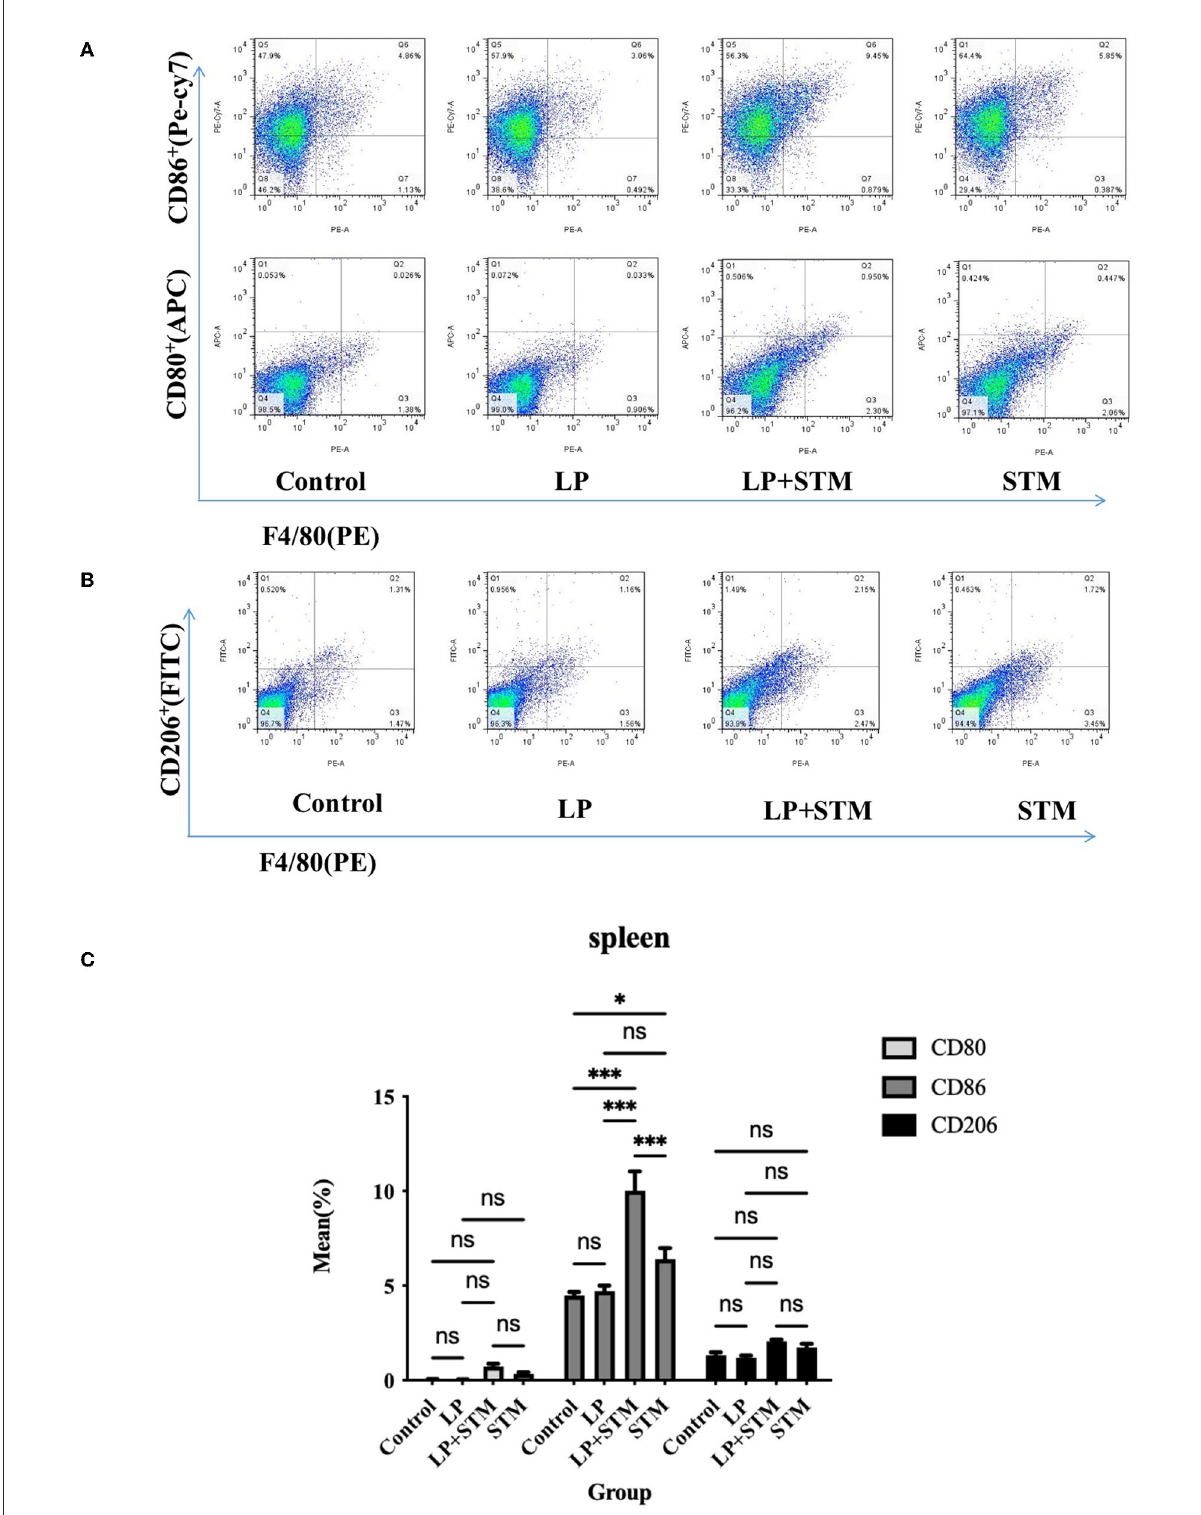
FIGURE5 LP pretreatment promoted M1 polarization in mouse spleen macrophages. (A,B) Representative analysis of percentage of F4/80 + CD80 + or F4/80 + CD86 + or F4/80 + CD206 + cells detected by flow cytometry in spleens from each group. (C) Statistics of the proportion of F4/80 + CD80 + , F4/80 + CD86 + , and F4/80 + CD206 + cells. Results are presented as means ± SD (data were analyzed using one-way ANOVA. ns not significant, * p < 0.05, ** p < 0.01, *** p <